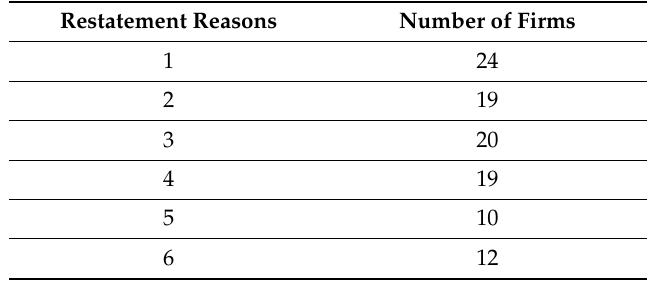
Table 5. Restatement analysis (The reasons for restatement shown in Appendix